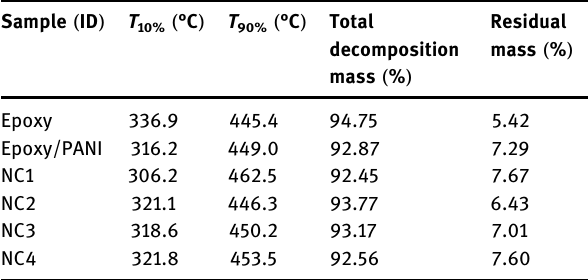
Table 2: TGA data of epoxy, epoxy/PANI, and epoxy/PANI/GNPs nanocomposites